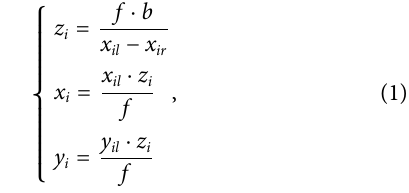
Frontiers in Robotics and AI |